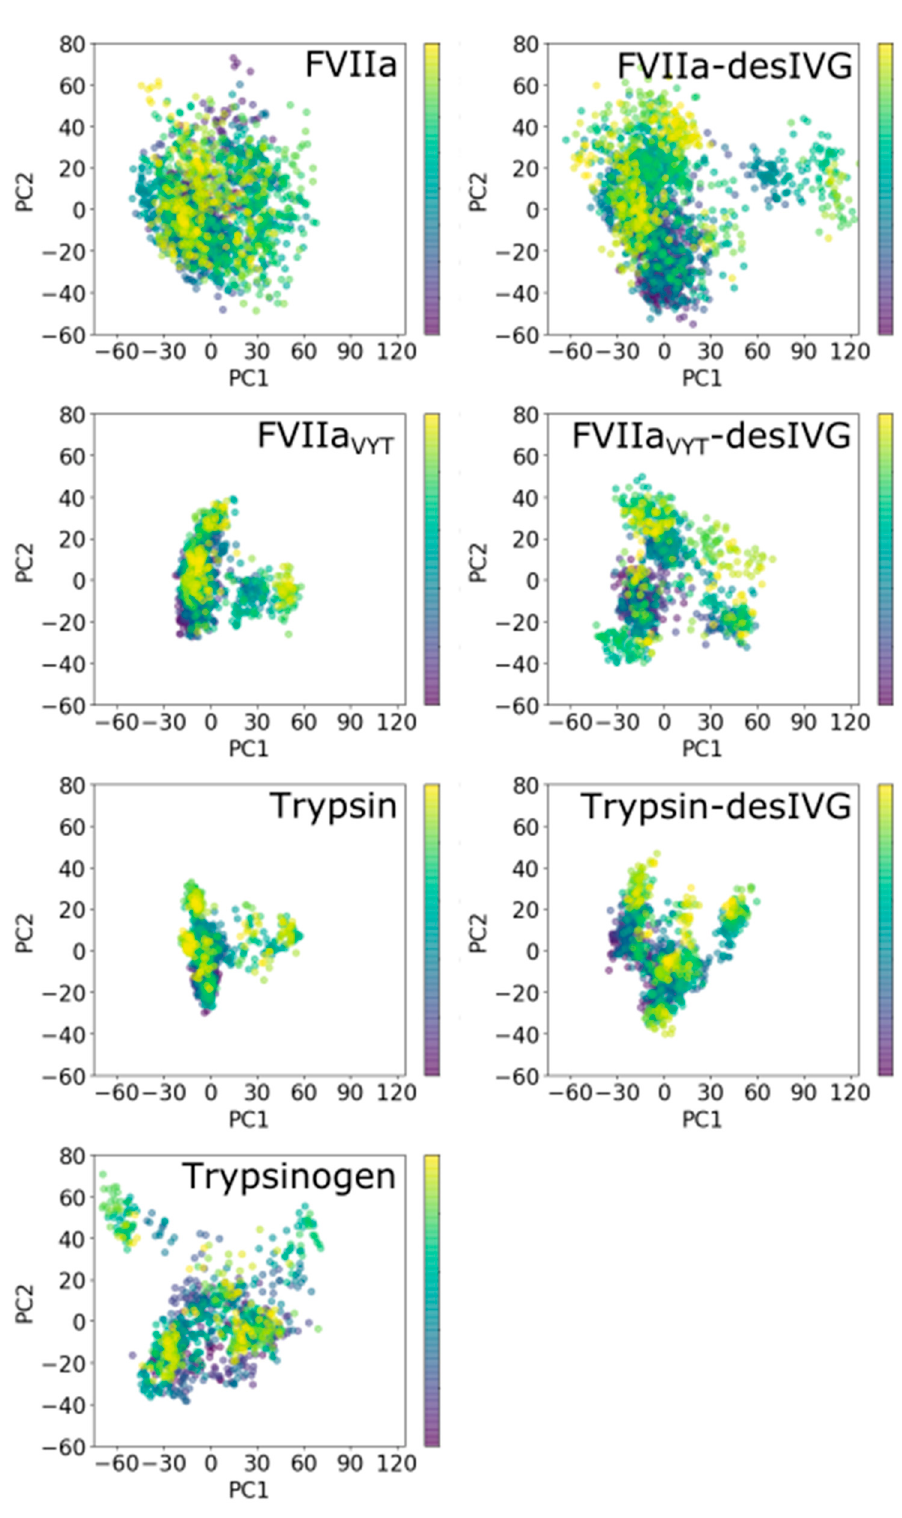
Figure 4. Principal component analysis of the simulated constructs. The plots show the first (PC1) and second (PC2) principal component against each other. The color bar scale indicates the simulation time starting from 0 ns (purple dots) to the end of the trajectory (yellow dots).